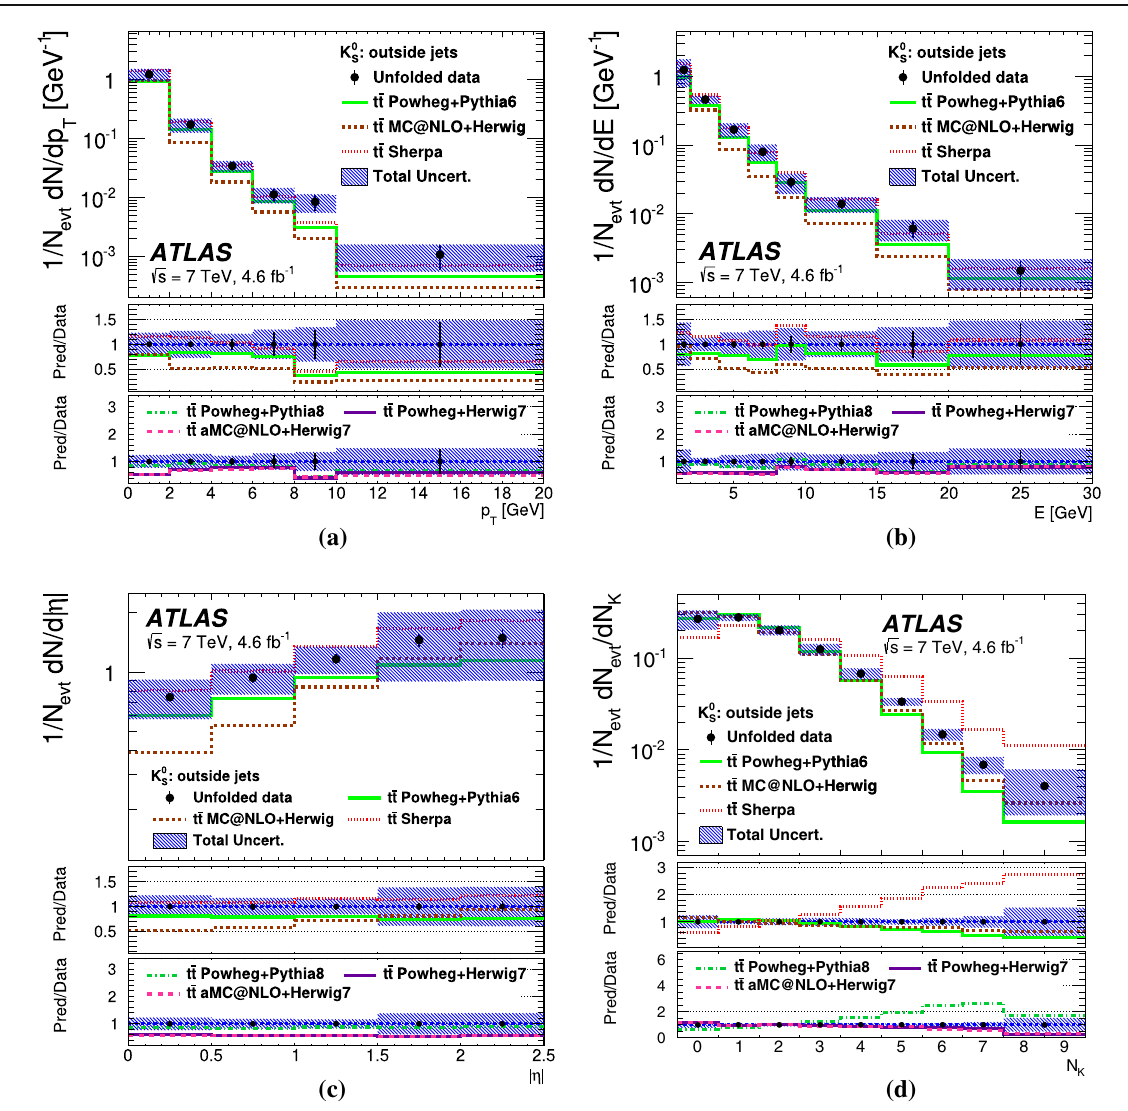
Pythia8 , Powheg + Herwig7 and a MC@NLO + Herwig7 genera- Fig. 10 Kinematic characteristics for K 0 production not associated S tors. Total uncertainties are represented by the shaded area. Statistical withjets,forcorrecteddataandparticle-levelMCeventssimulatedwith the Powheg + Pythia6 , MC@NLO + Herwig , Sherpa , Powheg + uncertainties for MC samples are negligible in comparison with